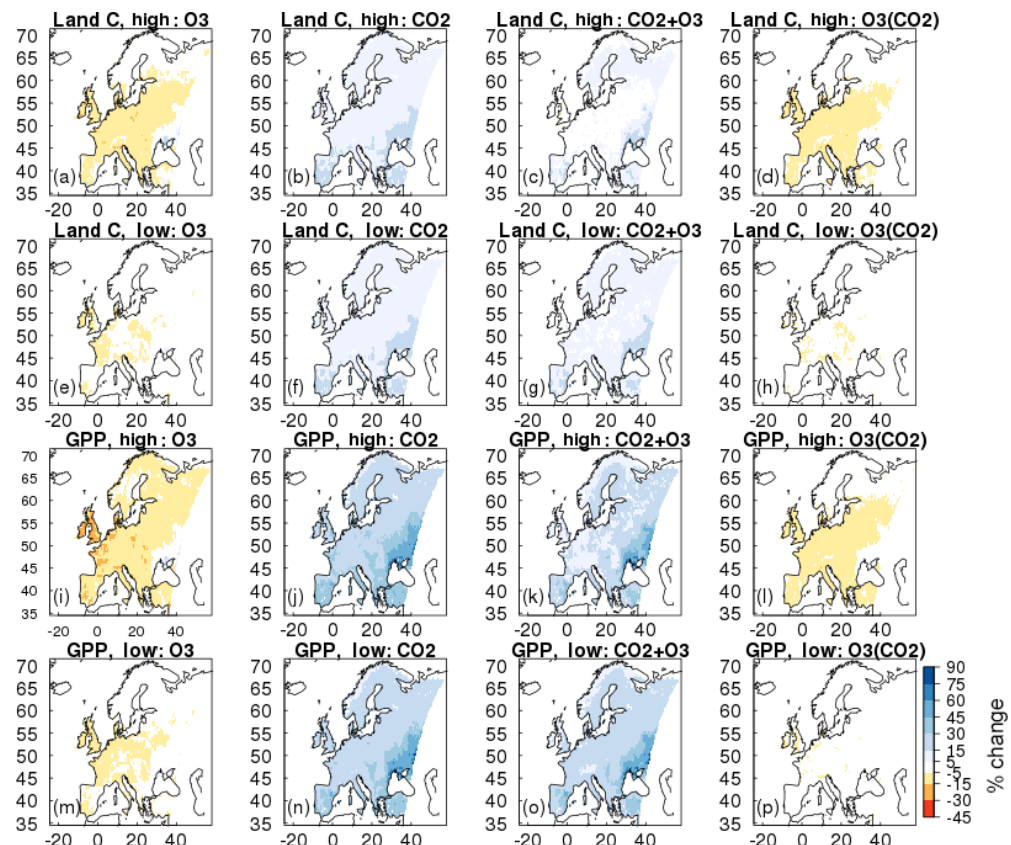
Figure 7. Simulated percentage change in total carbon stocks (Land C) and gross primary productivity (GPP) due to (i) (a, e, i, m) O 3 effects at fixed pre-industrial atmospheric CO 2 concentration (run_O 3 ), (ii) (b, f, j, n) CO 2 fertilisation at fixed pre-industrial O 3 concentration (run_CO 2 ), (iii) (c, g, k, o) the interaction between O 3 and CO 2 effects (run_both_CO 2 + O 3 ), and (iv) (d, h, l, p) O 3 effects with changing atmospheric CO 2 concentration (i.e. O 3 damage accounting for the effect of CO 2 -induced stomatal closure; run_both_CO 2 + O 3 – run_CO 2 ). Changes are depicted for the period from 1901 to 2050 for high and low ozone plant